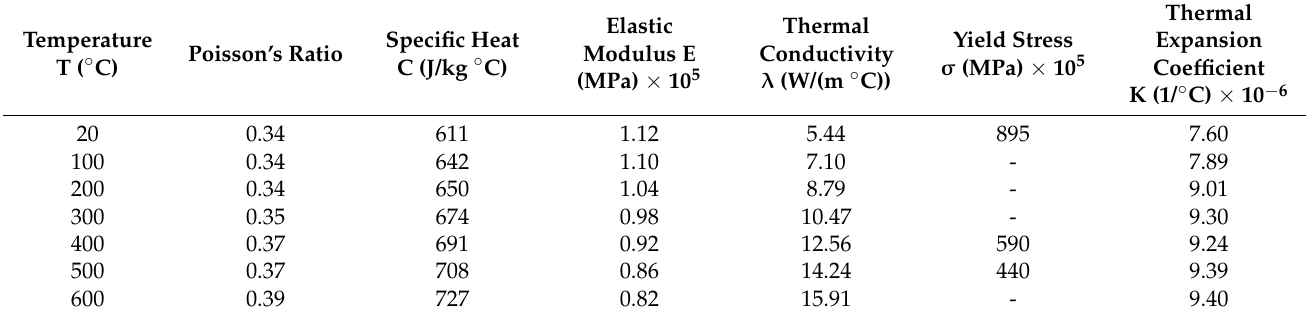
Table 1. Thermophysical performance parameters of Ti-6Al-4V.